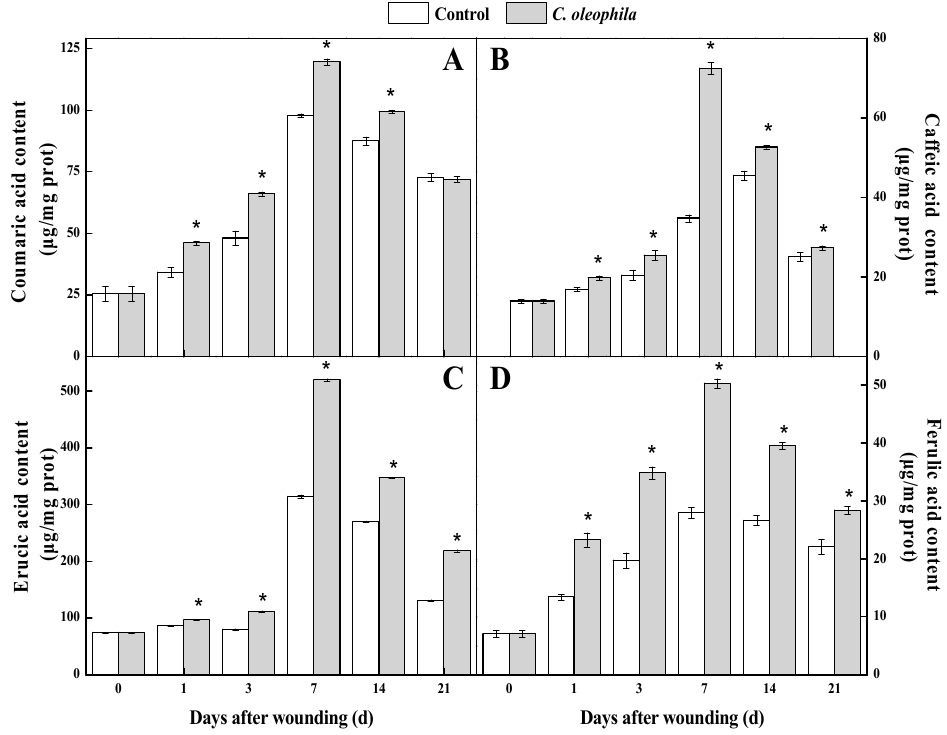
Figure 4. Effects of C. oleophila treatment on the content of coumaric acid ( A ), caffeic acid ( B ), erucic acid ( C ), and ferulic acid ( D ) at wound sites of tubers during healing. Bars indicate standard error (±SE). Asterisks indicate significant difference ( p < 0.05).